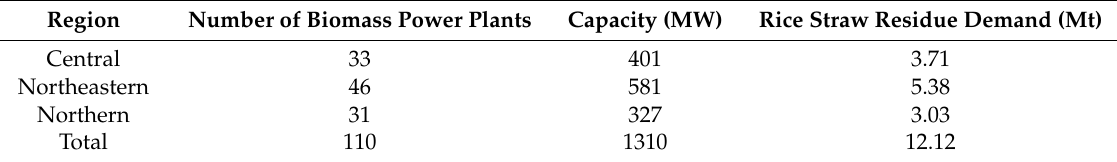
Table 6. Fuel demand of very small biomass power plants in Thailand, classified by